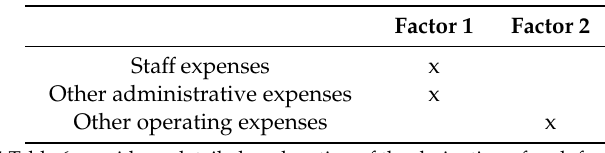
Table 3. Factor combination